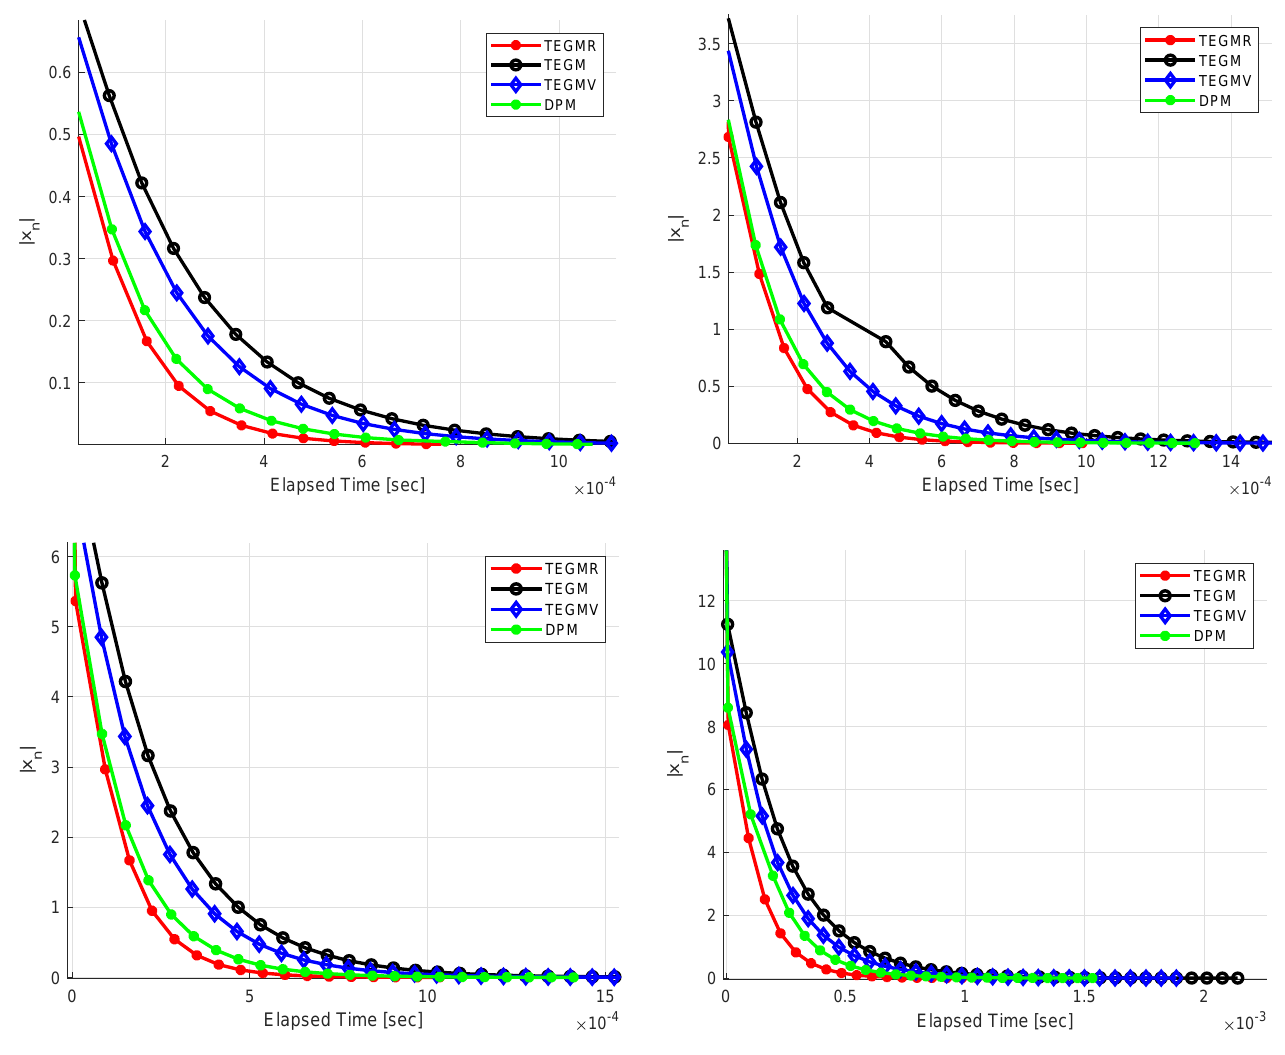
Figure 3. Example 1, top left : x 0 = 1; top right : x 0 = 5, bottom left : x 0 = 10, bottom right : x 0 = 15.